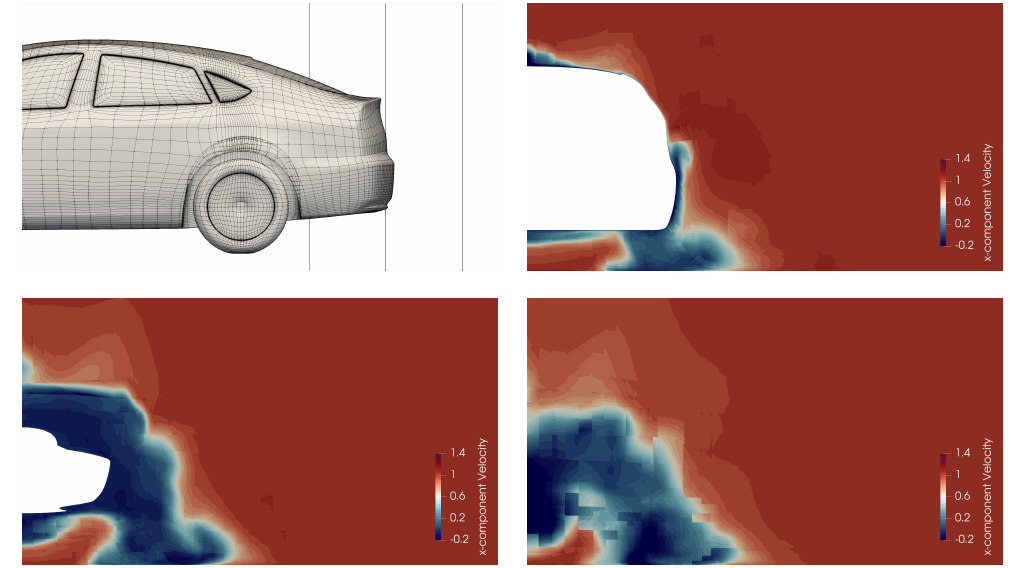
Figure 18. DrivAer model ( top , left )—Time-averaged x -velocity contours at different slices: x / L = 0.88 ( top , right ), x / L = 0.98 ( bottom , left ), and x / L = 1.10 ( bottom , right